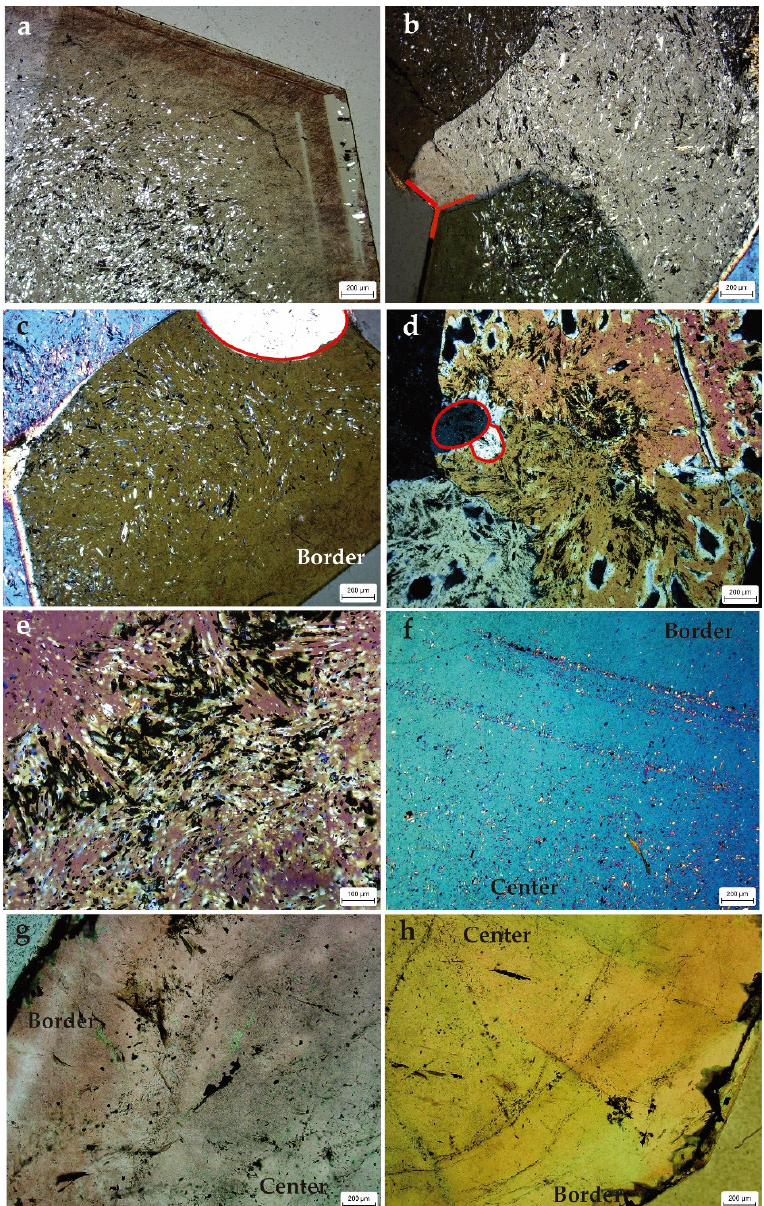
Figure 3. Euhedral quartz with hexagonal crystal shapes: ( a ) Cross-polarized light of a quartz crystal with abundant inclusions in the center and idiomorphic overgrowth towards the edges of the crystal; ( b ) Cross-polarized image of the quartz crystals, with crystal triple junctions (in red) that are clear and free of inclusions; ( c ) Cross-polarized image of another crystal where the pattern of the inclusion can be observed; ( d ) Cross-polarized image of the center of the crystal with abundant inclusions that change to bands free of inclusions towards the outer part; ( e ) Detail of the center of the crystal and the texture of the organic-rich inclusion; ( f ) Patches of elongate inclusions filled with organic matter and anhydrite laths in the central part of the crystal; ( g ) Plane-polarized light where the concretional morphology of the interior of the quartz marked by lineation of the organic matter inclusions. The external part of the crystal is free of inclusion; ( h ) Quartz appeared as idiomorphic crystals, although the inclusions-rich inner part revealed a dissolution surface in the interior of the crystal. To avoid the destruction of inclusions, thin sections were kept thicker and consequently changed the quartz interference colors in polarized light.